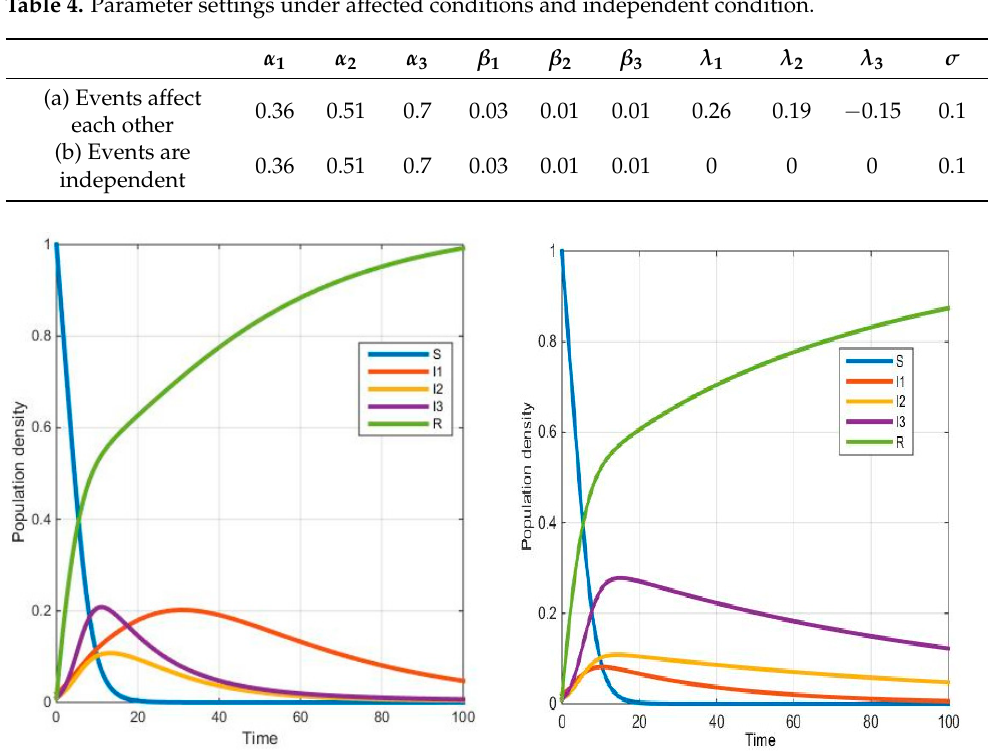
Figure 3. Population change trend of various groups. Table 4. Parameter settings under affected conditions and independent